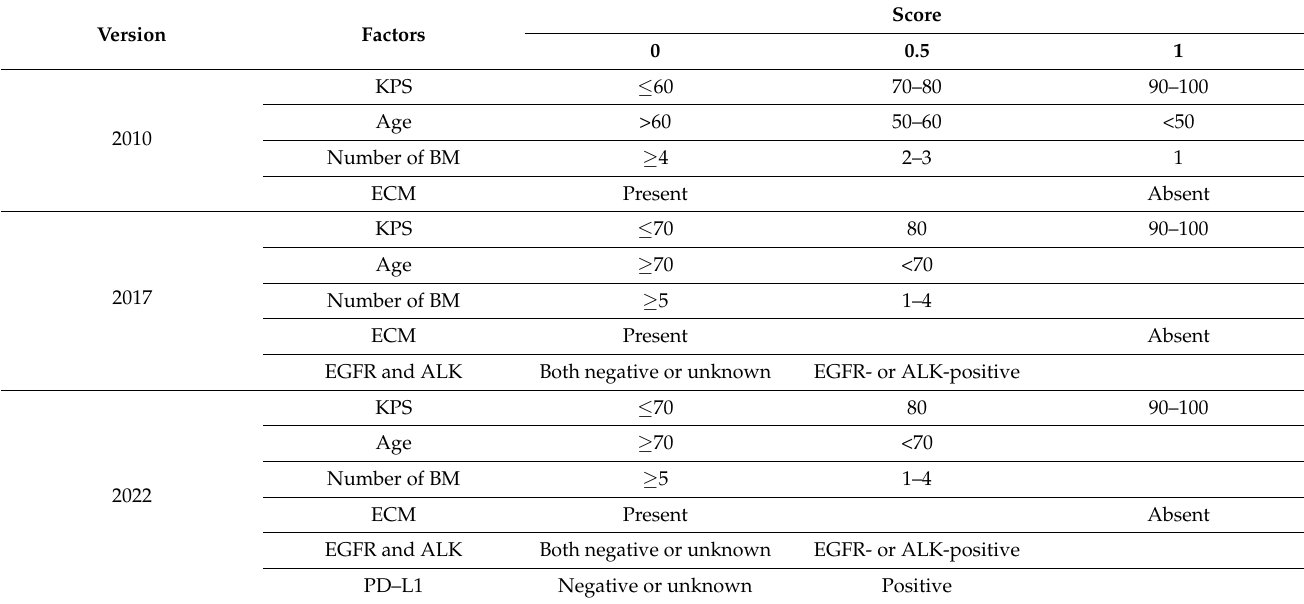
Table A1. Graded prognostic assessment (GPA) index of patients with newly diagnosed lung adenocarcinoma with brain metastases.